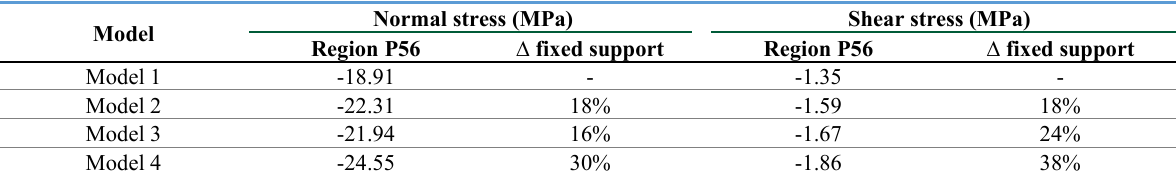
Table 8. Maximum values of normal and shear stresses of wall